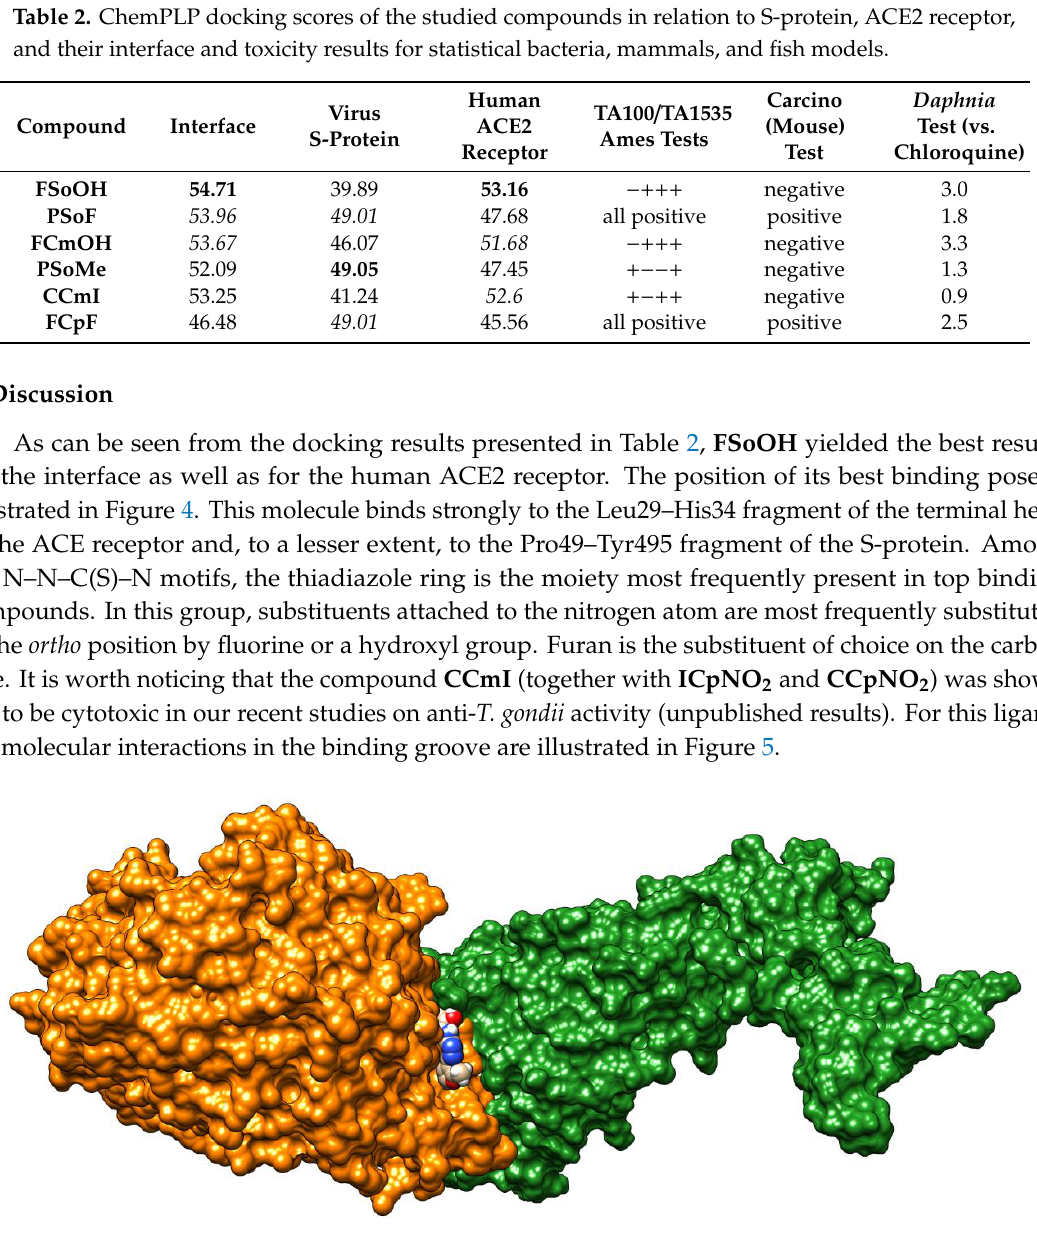
Figure 4. The best binding pose of FSoOH at the virus spike protein (S-protein, green)–human ACE2 receptor (orange) interface.